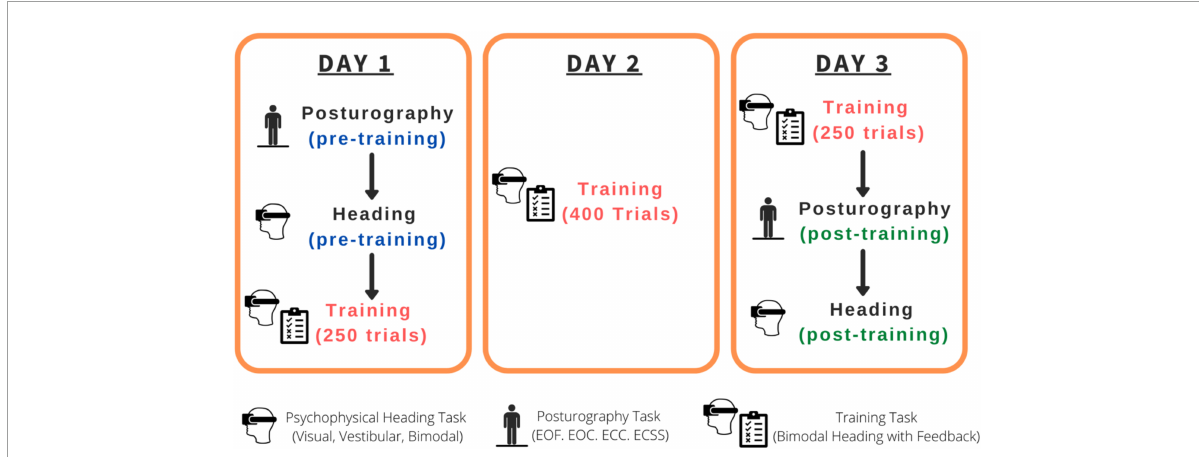
FIGURE1 Order of the tasks completed for each participant. EOF, Eyes-open on a firm surface; EOC, Eyes-open on a compliant surface; ECC, Eyes-closed on a compliant surface; ECSS, Eyes-closed on a compliant surface, wearing passive sound-suppressing headphones.